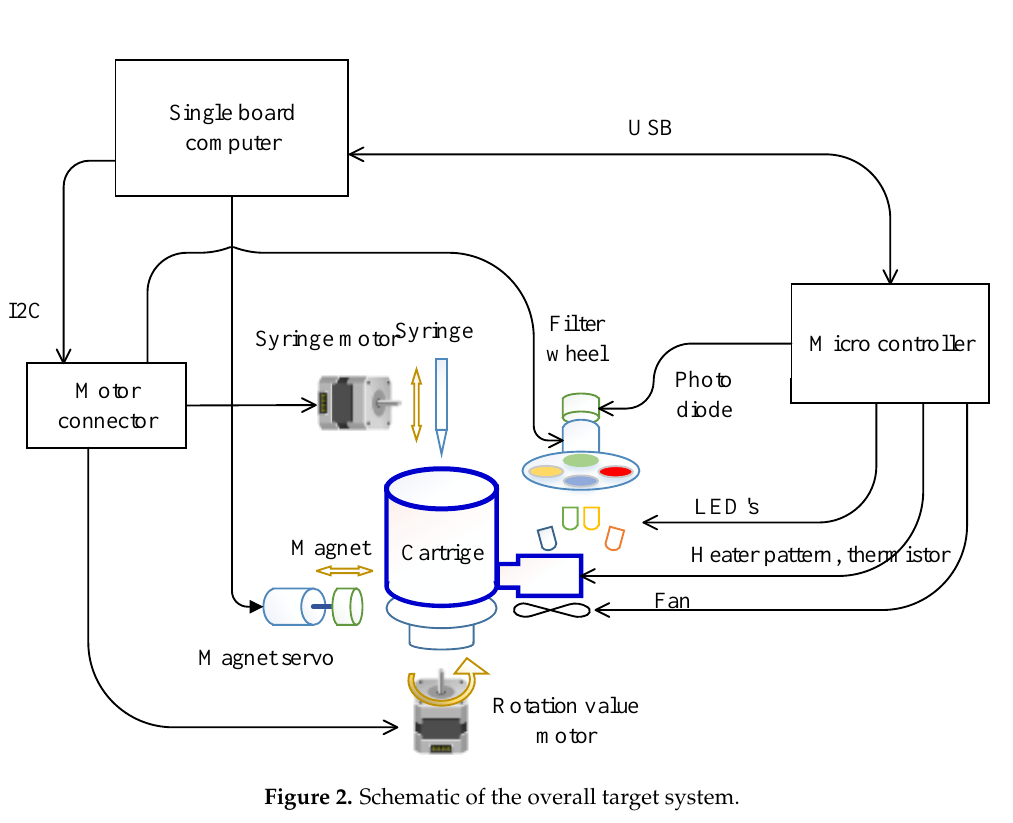
Figure 2. Schematic of the overall target system.